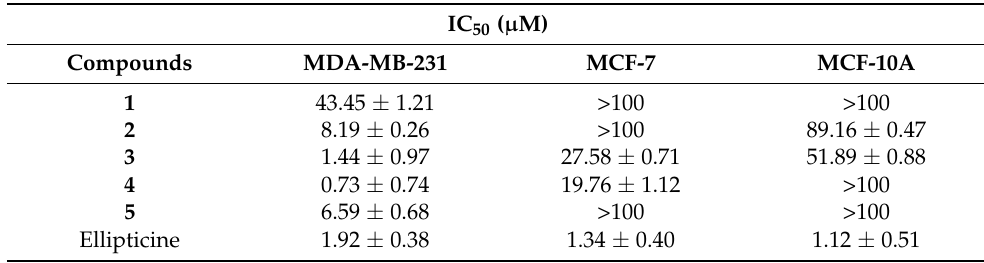
Table 1. IC 50 values of carbazoles derivatives and Ellipticine expressed in µ M. The means ± standard deviations are